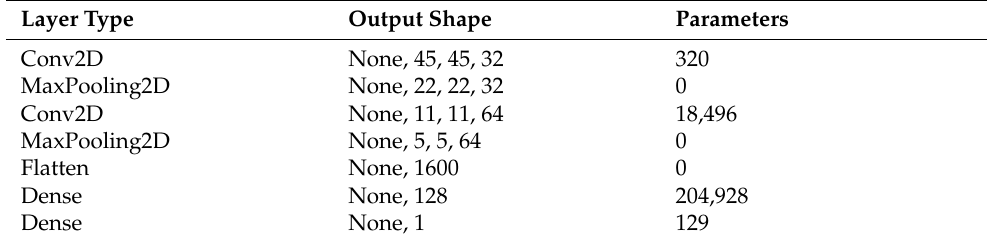
Table 1. The constructed base typical CNN